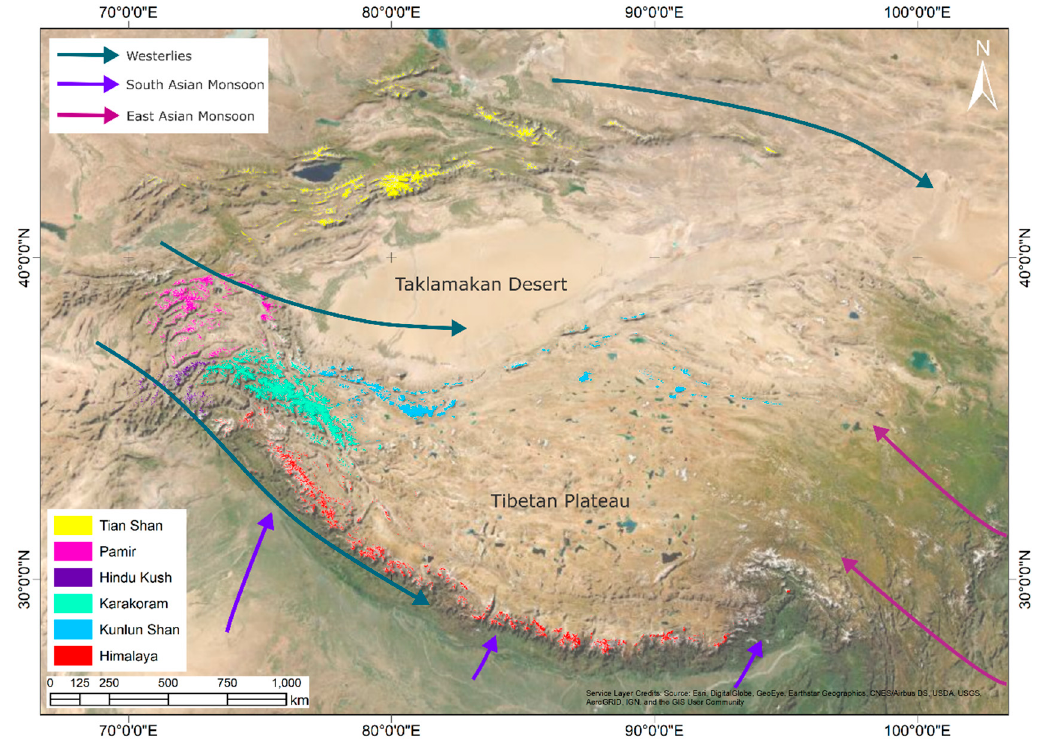
Figure 2. Map of HMA sub-regions using RGI v6.0. Coloured areas correspond to simplified sub-regional glacier data exported from RGI v6.0, a supplemental inventory to the GLIMS glacier database. Arrows indicate air mass influences across HMA.